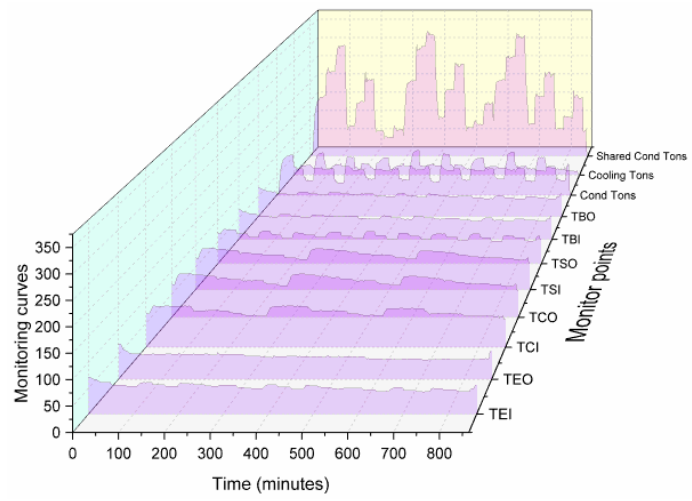
Figure 5. Visualization data.